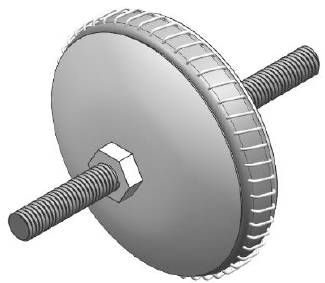
Figure 12. Flexible connection device based on spring damping.